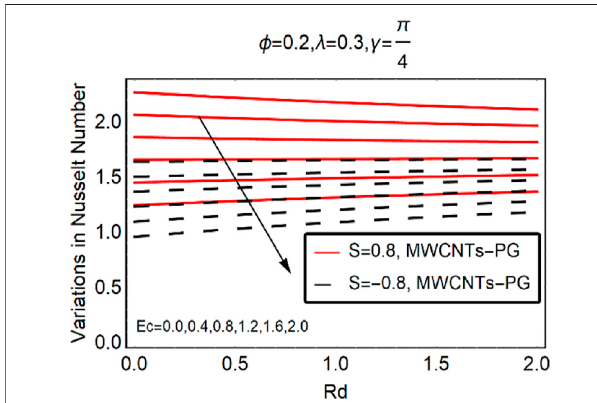
FIGURE 10 | The local thermal performance rate against Ec and